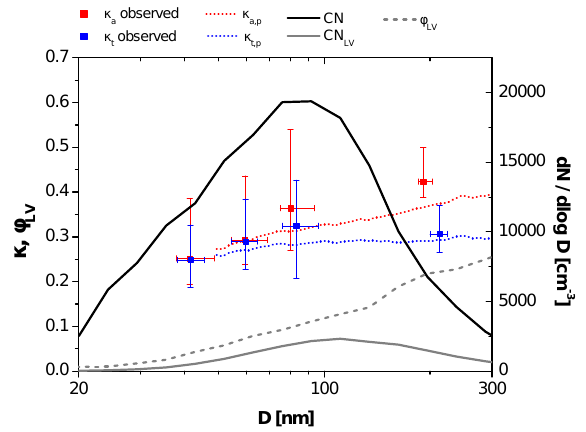
Fig. 11. Comparison of the predicted (red and blue lines, left axis) and measured (red and blue data points, left axis) hygroscopicity parameters. Supporting lines are the number size distribution of CN (solid black, right axis), of LV-particles (solid grey, right axis), and of the fraction of LV-particles (dashed grey, left axis) averaged over the campaign. Lines and data points are median values, and error bars indicate the interquartile ranges of the corresponding data